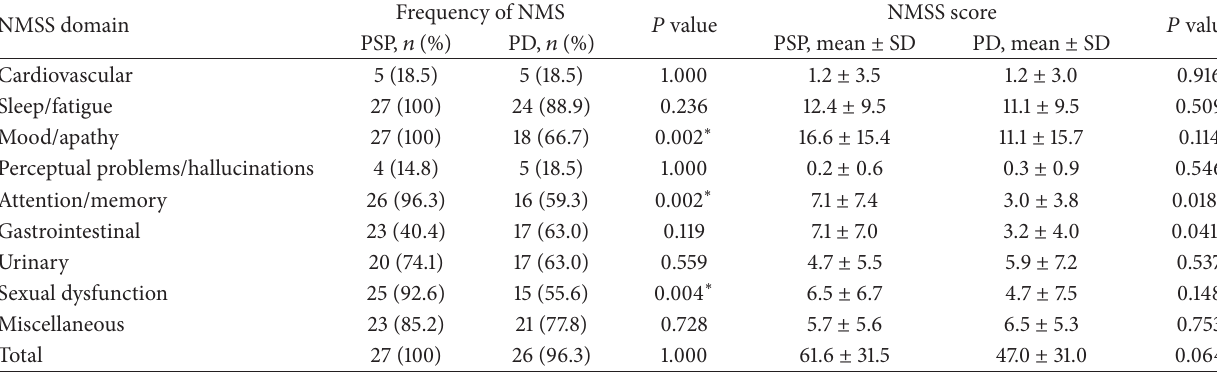
Table 3: Frequency of NMS and mean NMSS scores in PSP and PD.